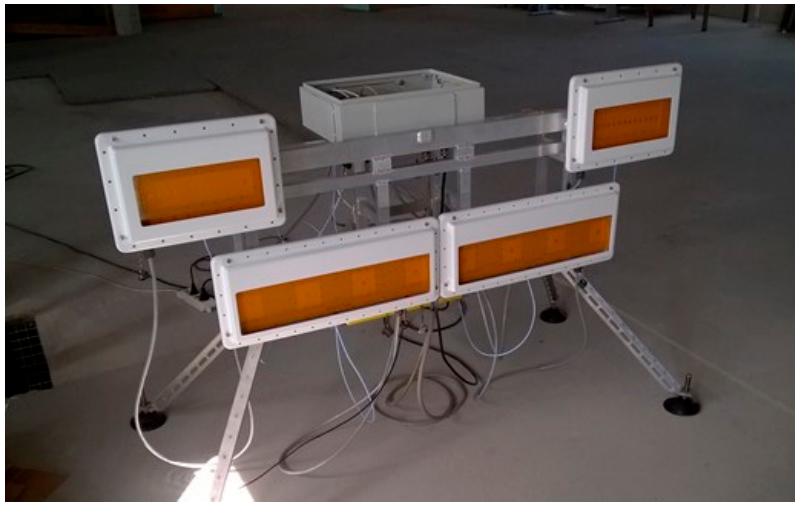
Figure 5. SPARX array prototype.